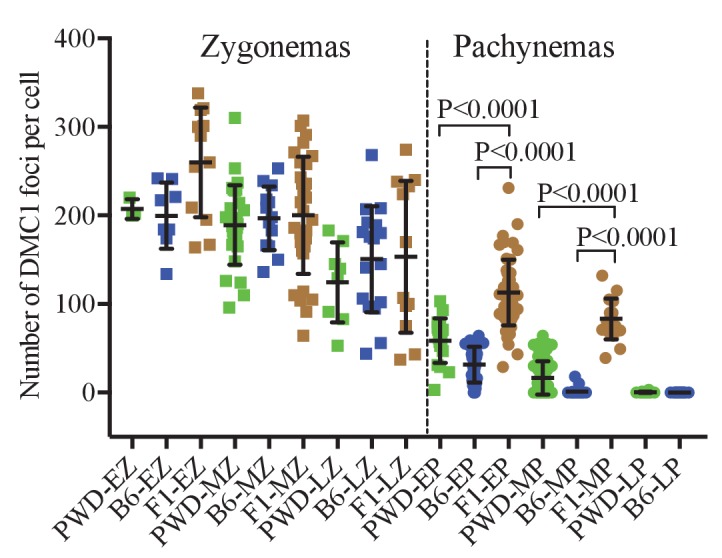
DMC1 foci in spermatocytes of PWD, B6 and (PWDxB6)F1 males.The numbers of DMC1 foci per cell in cisPt untreated males do not show significant differences at the zygotene stage. The extent of DSB repair failure in early and mid-pachynemas of PBF1 hybrids is reflected by significant persistence of DMC foci compared to both parental strains.10.7554/eLife.42511.012Figure 4—figure supplement 1—source data 1.DMC1 foci in spermatocytes of PWD, B6 and PBF1 males.